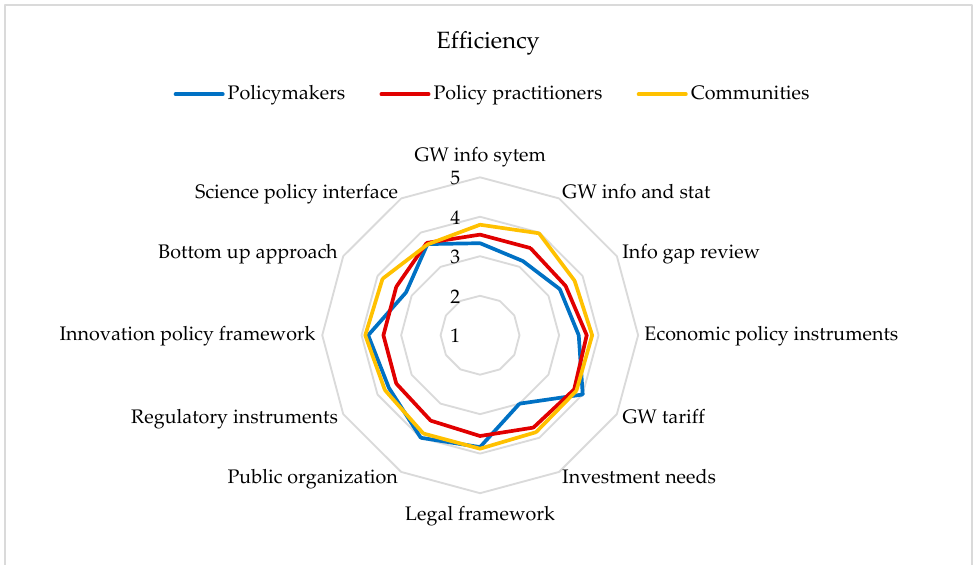
Figure 6. Efficiency dimension of groundwater governance.